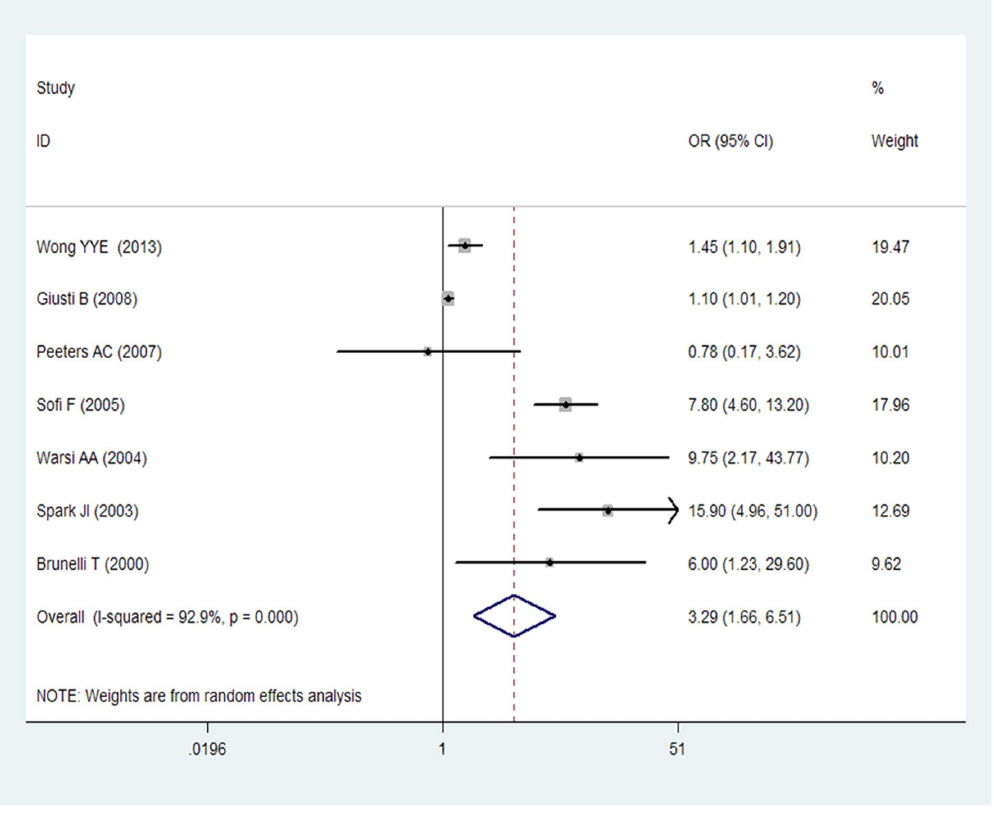
Figure 2. OR and 95% CI from the included studies of plasma Hcy level and AAA. doi:10.1371/journal.pone.0085831.g002 PLOS ONE |